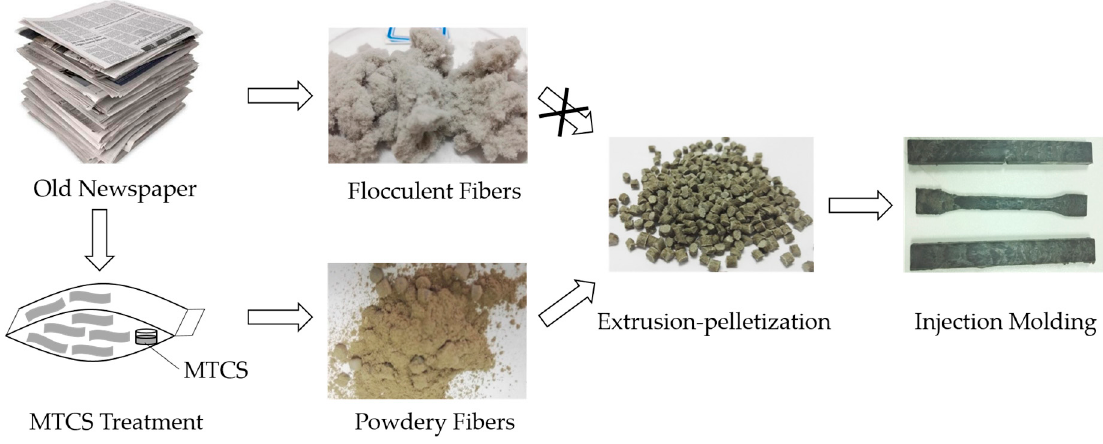
Figure 1. Schematic diagram of old newspaper (ONP)/high-density polyethylene (HDPE) composite preparation.